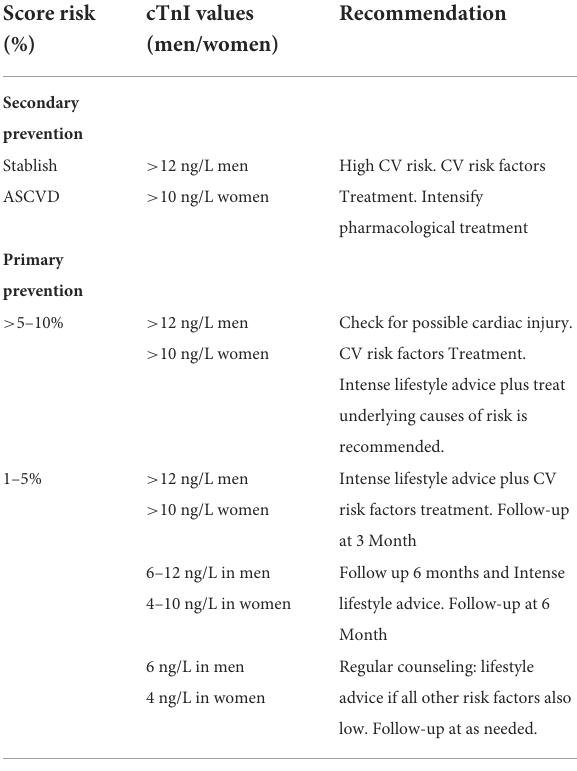
TABLE 1 Recommendations for the use of cTnI in primary and secondary prevention: A tentative